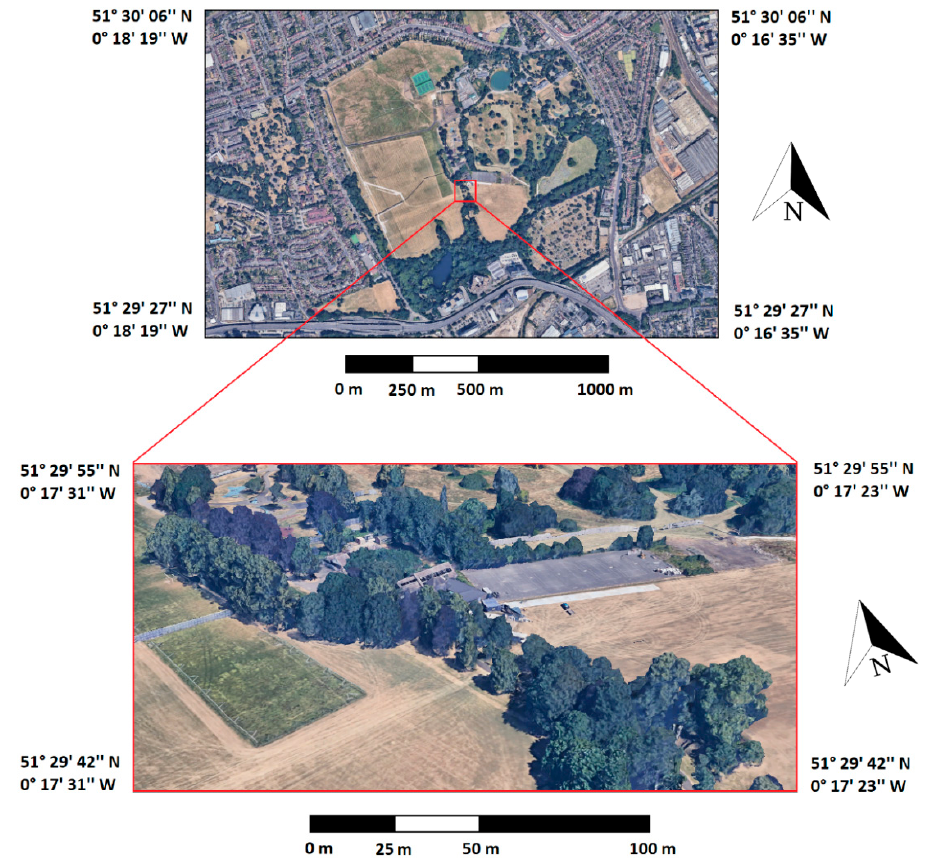
Figure 1. Study site for the GPR investigation (map data: Google, Landsat/Copernicus).